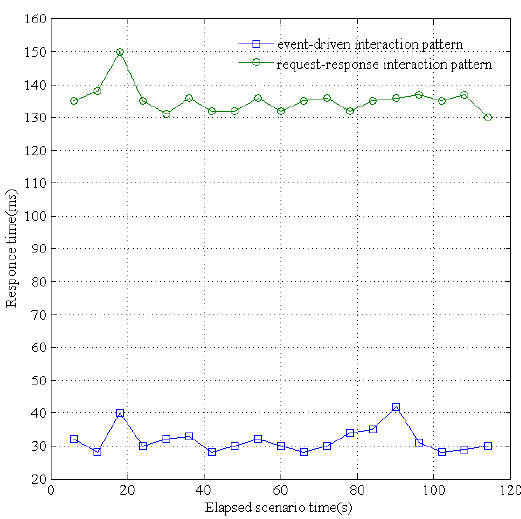
Figure 18. Service response time of event-driven and request-response.